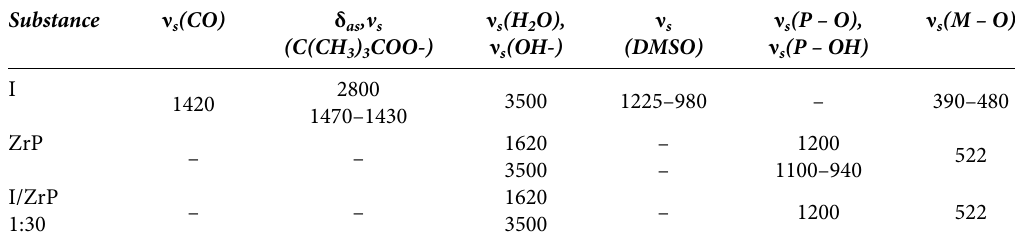
Table 1: Characteristic frequencies (сm –1 ) and their correspondence in the FT-IR spectra of I , ZrP and I /ZrP